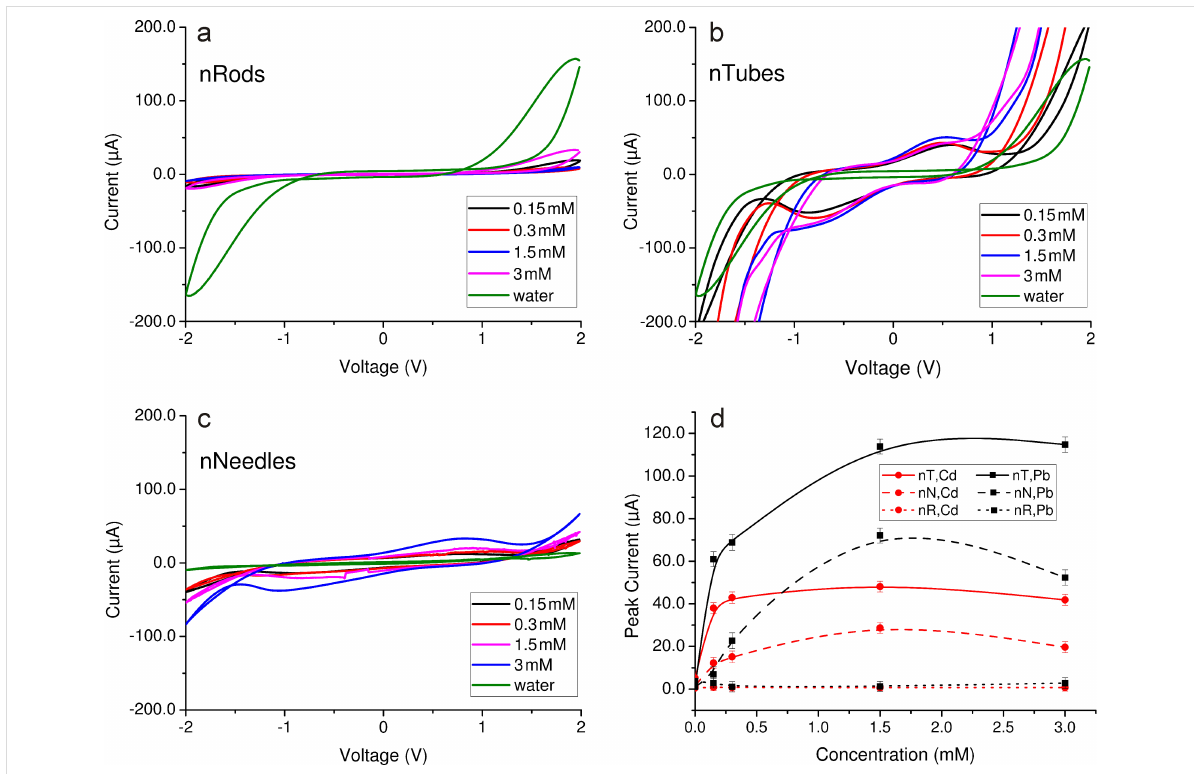
Figure 5: CV curves of aqueous Cd(NO 3 ) 2 solution on ZnO electrodes with different morphologies: (a) nanorods, (b) nanotubes, (c) nanoneedles and (d) CV reduction peak dependence on Cd(NO 3 ) 2 concentration for all morphologies and its comparison with the analogous curves for Pb(NO 3 ) 2 con- centration (the data taken from Figure